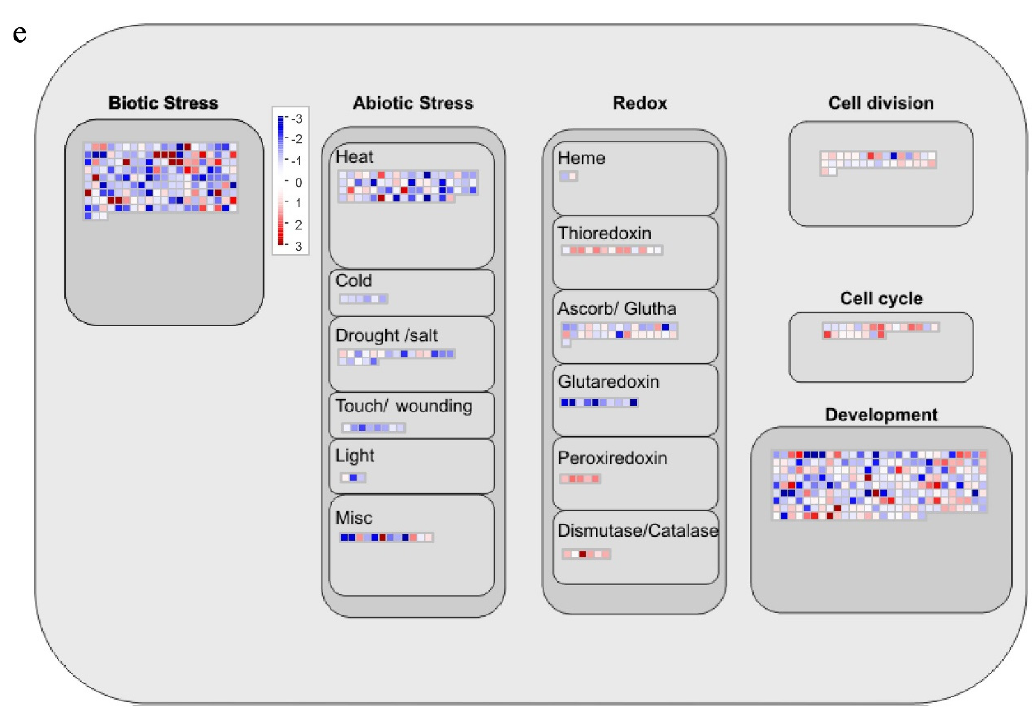
Figure 10. Cluster pattern of DEGs produced via MapMan. ( a ) DEG modulation overview for Frl tomato at 0–3 dpi. ( b ) DEG modulation overview for MM tomato at 0–3 dpi. ( c ) Biotic stress and DEG regulation in Frl tomato vs. MM tomato at 3 dpi. ( d ) Cell reaction and DEG regulation in Frl tomato at 0–3 dpi. ( e ) Cell reaction and DEG regulation in MM tomato at 0–3 dpi.